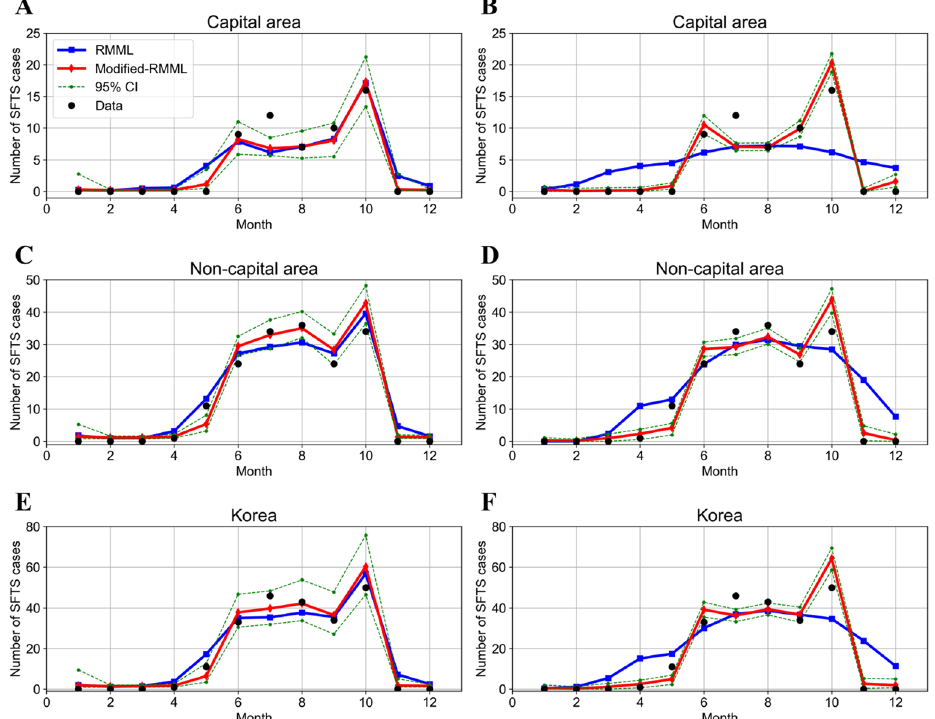
Figure 4. Comparison of the results of the regression model in machine learning (RMML) and modified regression models (modified-RMMLs) to estimate the number of severe fever with thrombocytopenia syndrome (SFTS) cases. Capital area ( A – B ), non-capital area ( C – D ), and Korea ( E – F ). The black dots represent the observed cases. The blue solid lines and red solid lines indicate the estimated SFTS cases from the RMML and modified-RMML, respectively. The 95% confidence intervals of the modified-RMML are shown in green dashed lines. The results of the two models using the bagging tree regression approach are shown in ( A , C , and E ), and the results obtained from the artificial neural network (multi-layer perceptron regression) are shown in ( B , D , and F